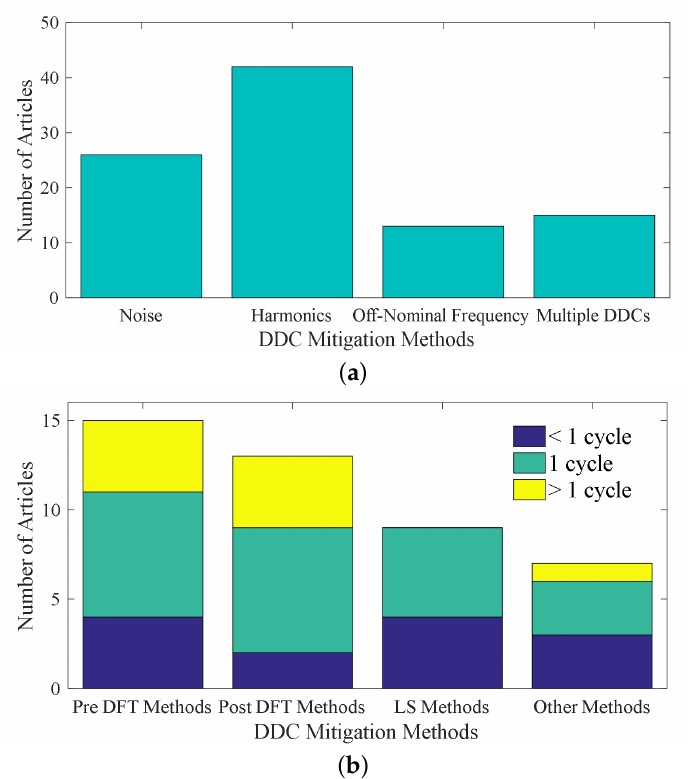
Figure 4. The overall statistics of the presented works (from 1976 to 2022) in terms of important parameters. ( a ) Summary of different articles in case of four destructive factors, which are included in an analytical approach or through simulation results. ( b ) The statistics of DDC mitigation methods in case of the required samples for accurate phasor